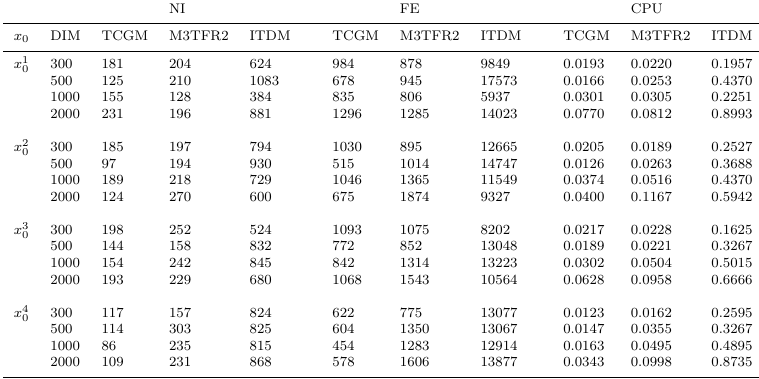
Table 6. Numerical results of Problem